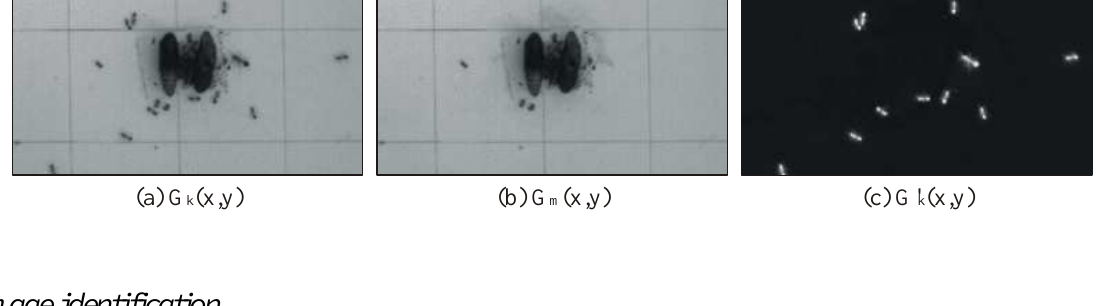
Figure 3. Sample images (256 · 128 pixels). (a) Raw image, (b) Averaged, (c)